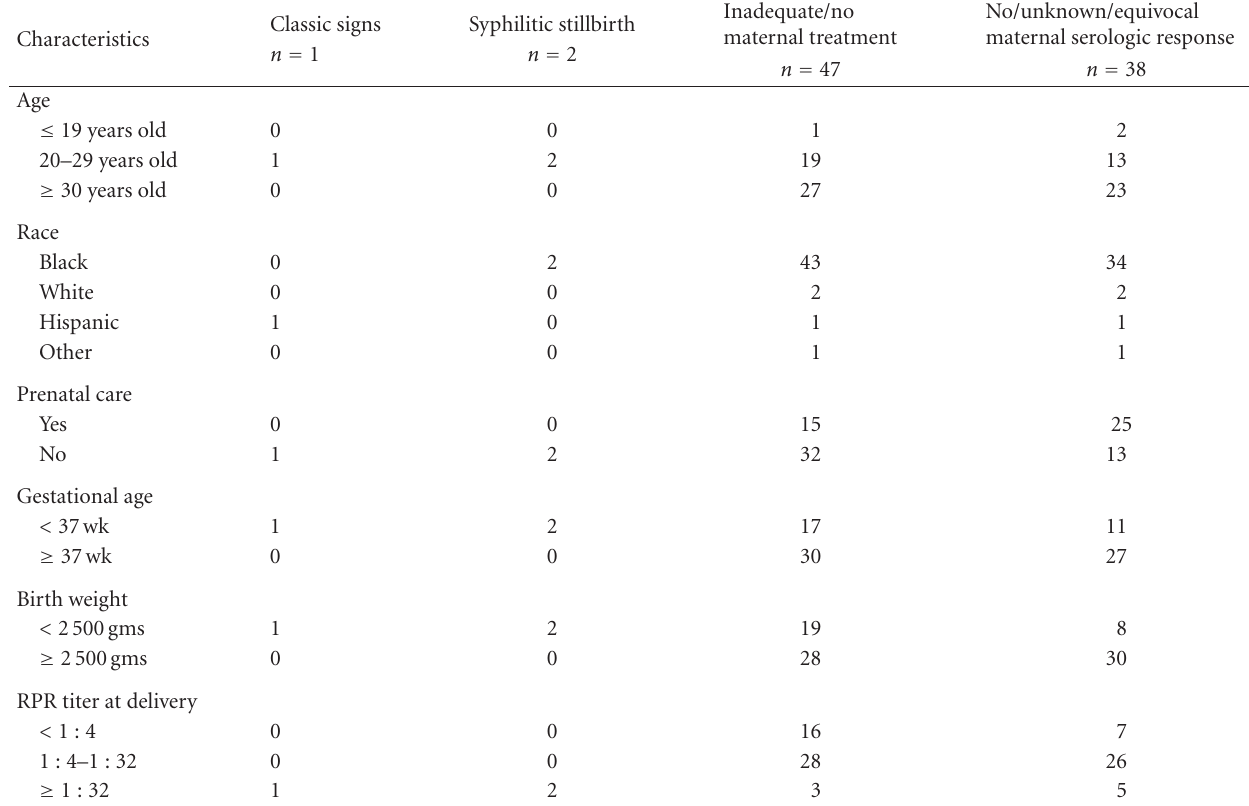
Table 3: Patient characteristics in reported congenital syphilis cases in Detroit during years